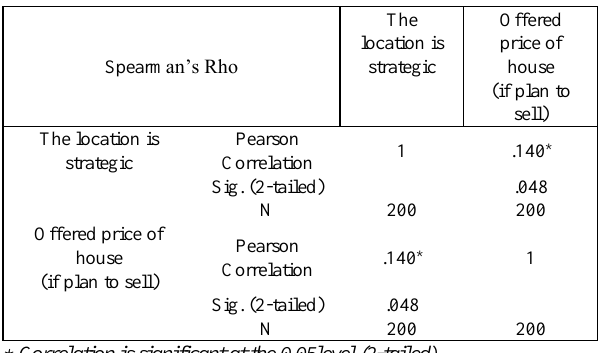
Table 3: Correlation between strategic location of open space and offered house